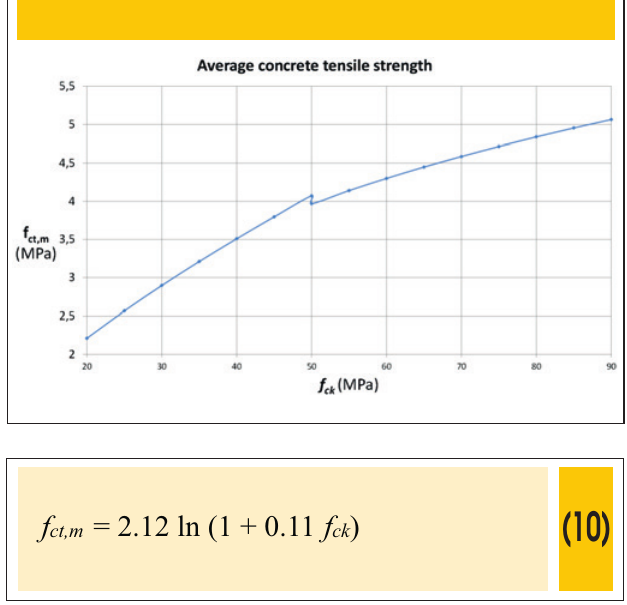
Figure 3 – Variation of parameters n, e e e